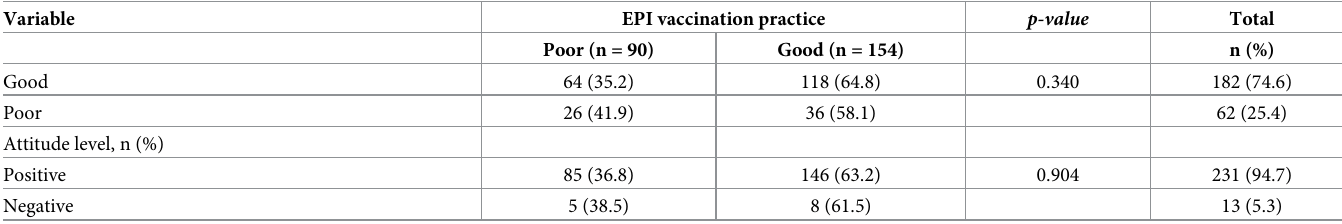
Table 2. Logistic regression analysis to assess factors associated with good childhood immunization practice among Rohingya parents. Variables